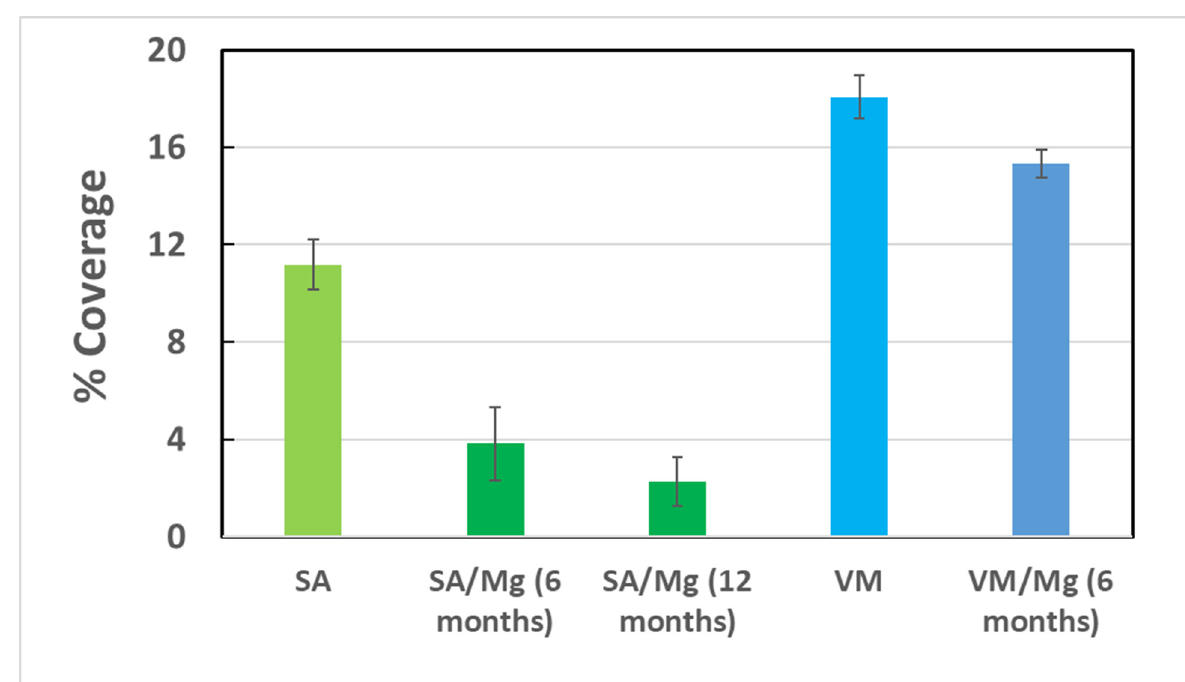
Figure 6. Summary of Coverage evaluation performed on sea-exposed samples.